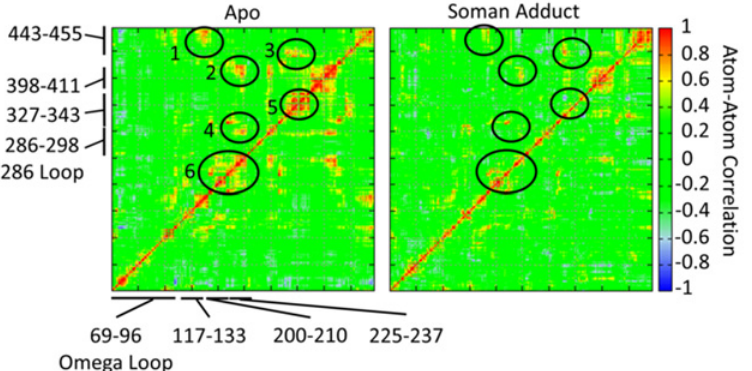
Fig 14. Normalized correlation matrices for all heavy atoms within 20 Å of the Ser203 hydroxyl oxygen atom for the apo and soman-adducted AChE. Residue numbers are shown for significant portions of the primary sequence. Positive correlations between near and distant residues is significantly decreased when soman is present. These areas of missing correlation are highlighted with ellipses. Additional negative correlation is observed between the 286 Loop and residues 443 – 455 in the soman adducted protein. The soman adduct appears to decouple positive correlative motions within a radius of 20 Å from the active